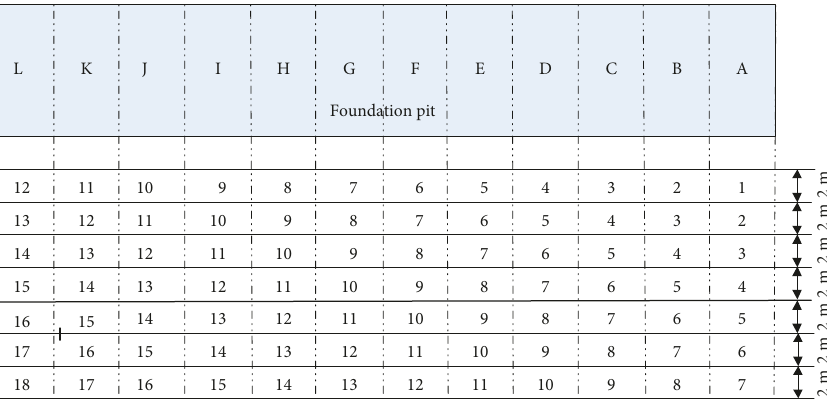
Figure 10: First excavation mode ( W 1).